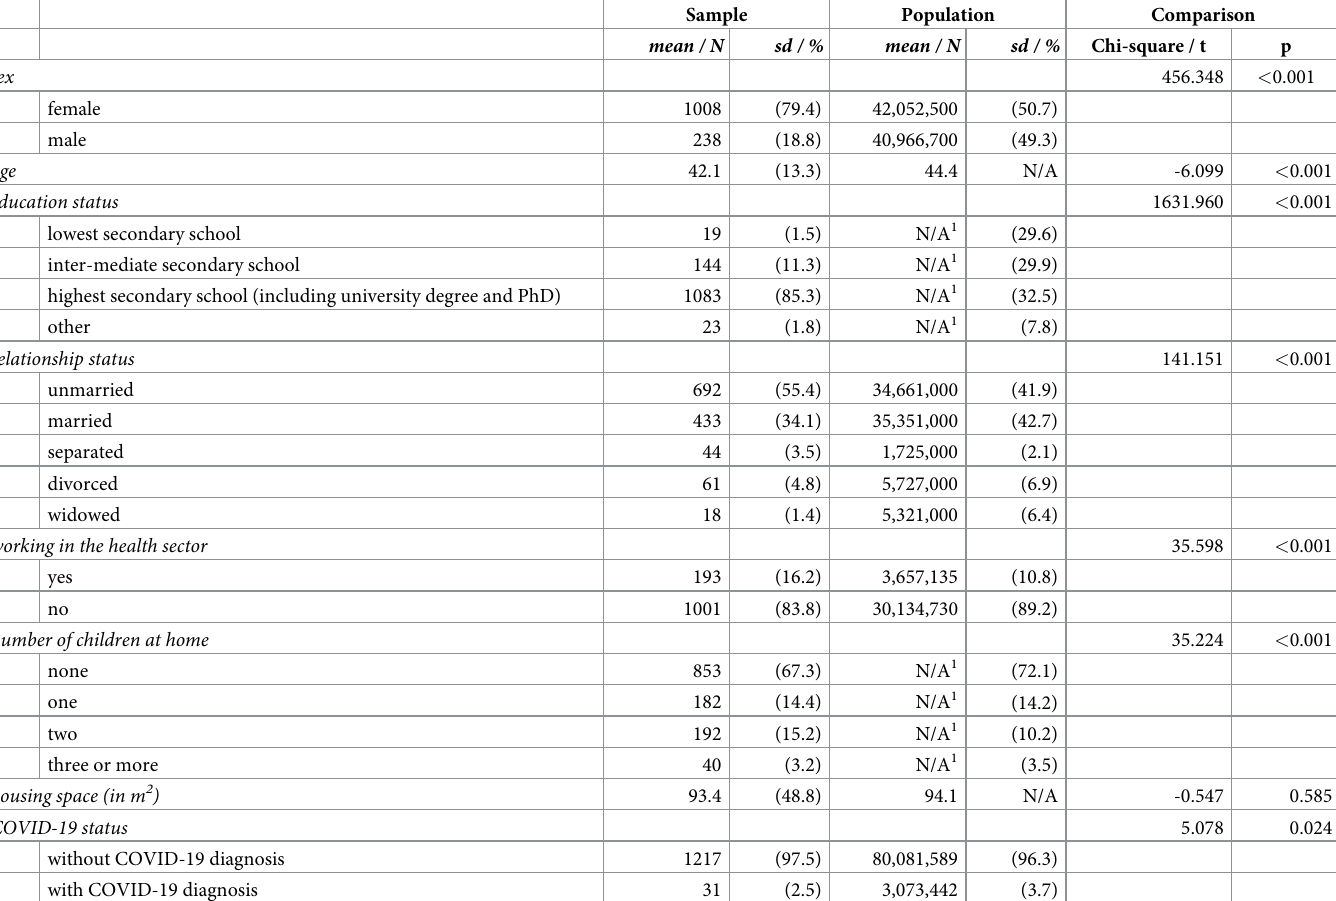
Table 1. Comparison of sample characteristics to population values, numbers per category except where